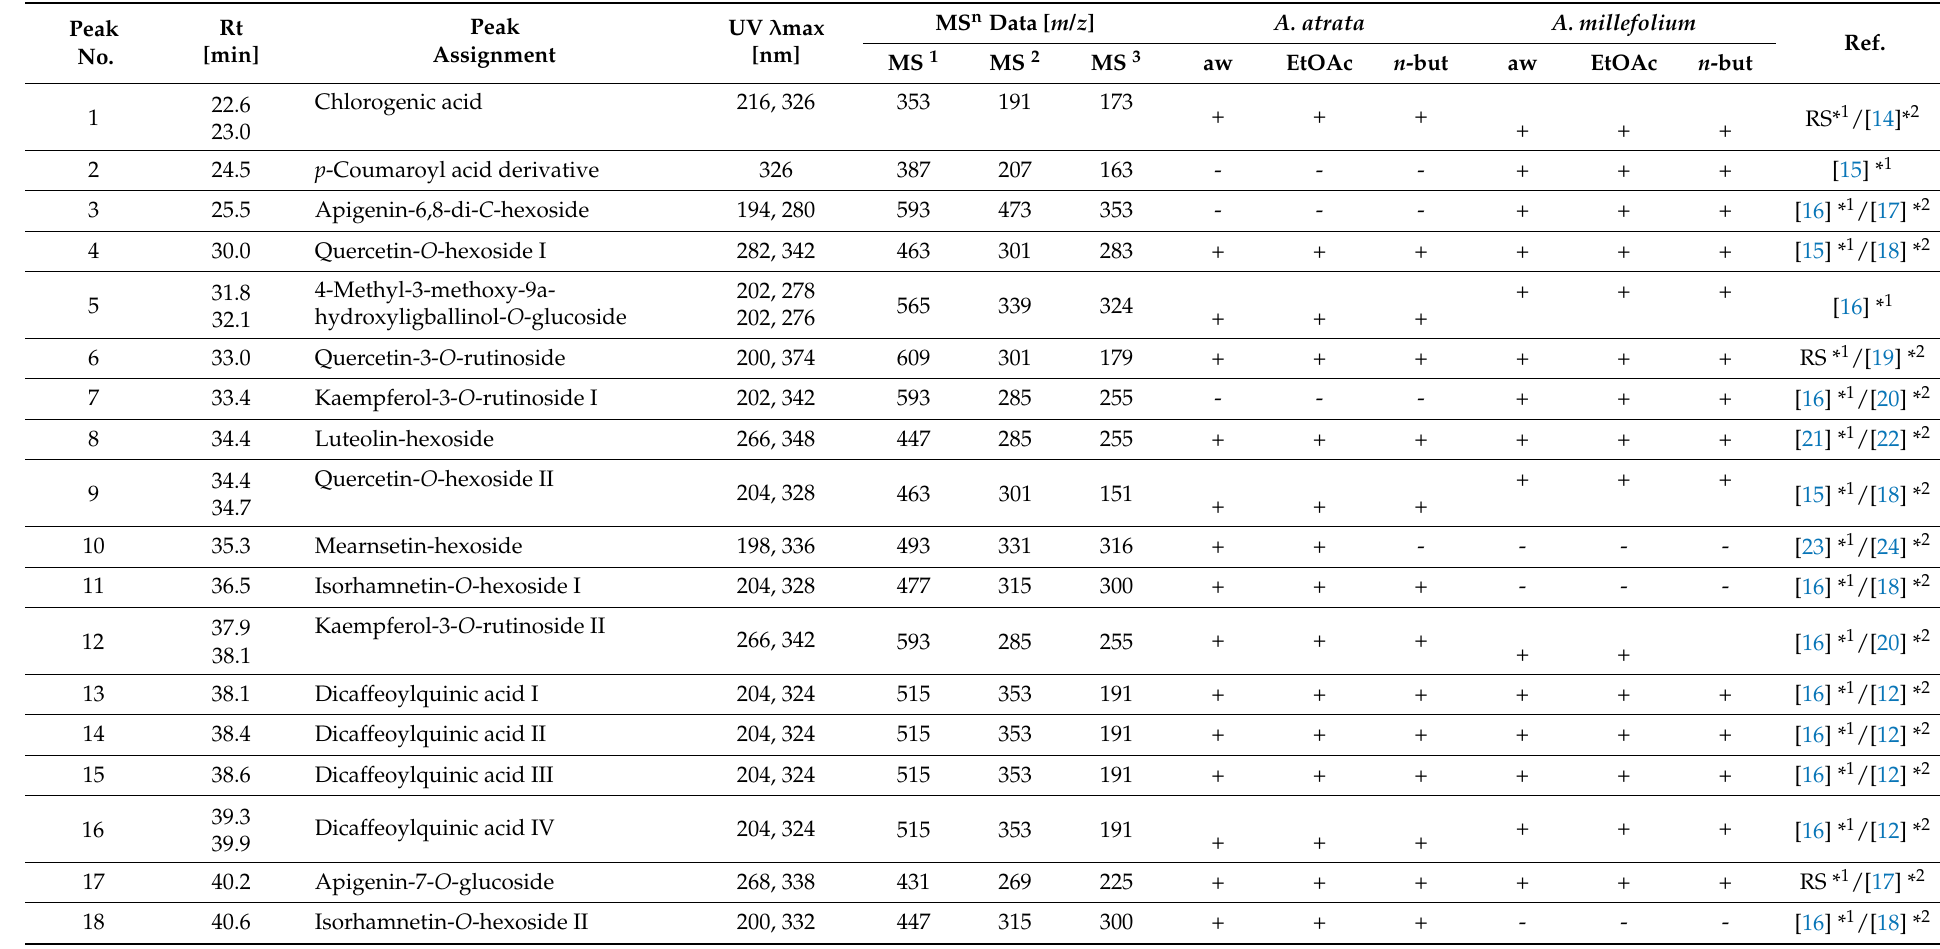
Table 1. Spectroscopic data (UV, mass spectrometry (MS)) and high performance liquid chromatography (HPLC) retention times (Rt) of secondary metabolites of A. atrata and A. millefolium [acetone/water extracts (aw), ethyl acetate fractions (EtOAc) and n -butanol fractions ( n -but)]. Only the most intense m/z ratios of the collision-induced dissociation (CID) experiments are